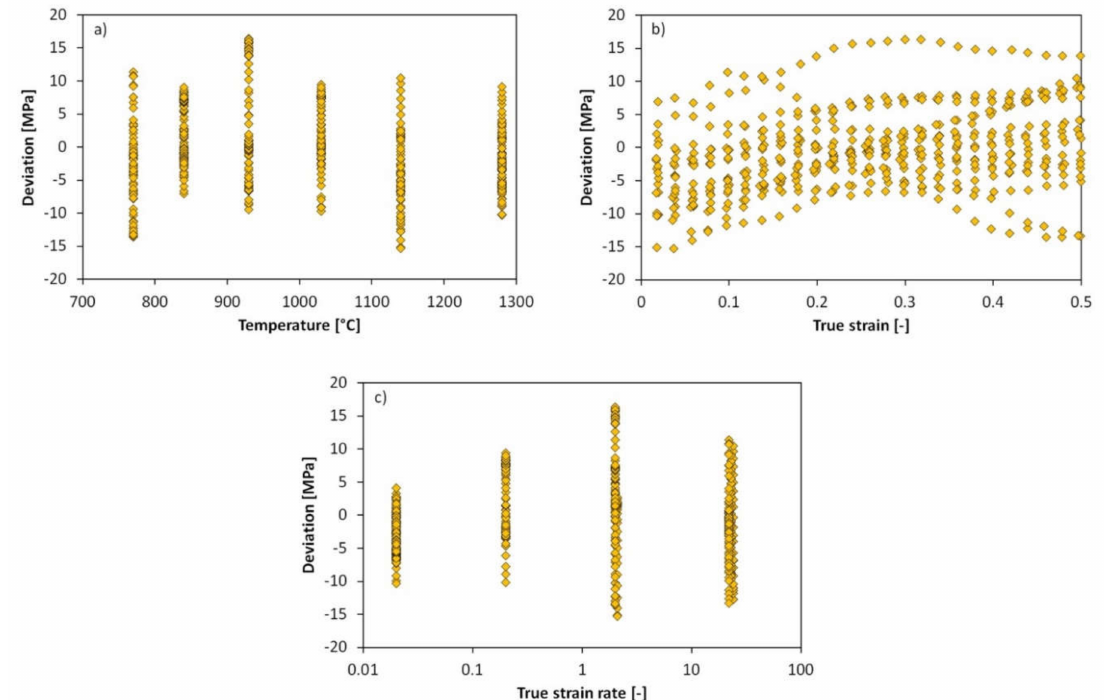
Figure 27. Distribution of flow stress deviations when applying Equation (9) to the experimental data depending on the parameters of individual tests. ( a ) Influence of temperature; ( b ) influence of strain; ( c ) influence of strain